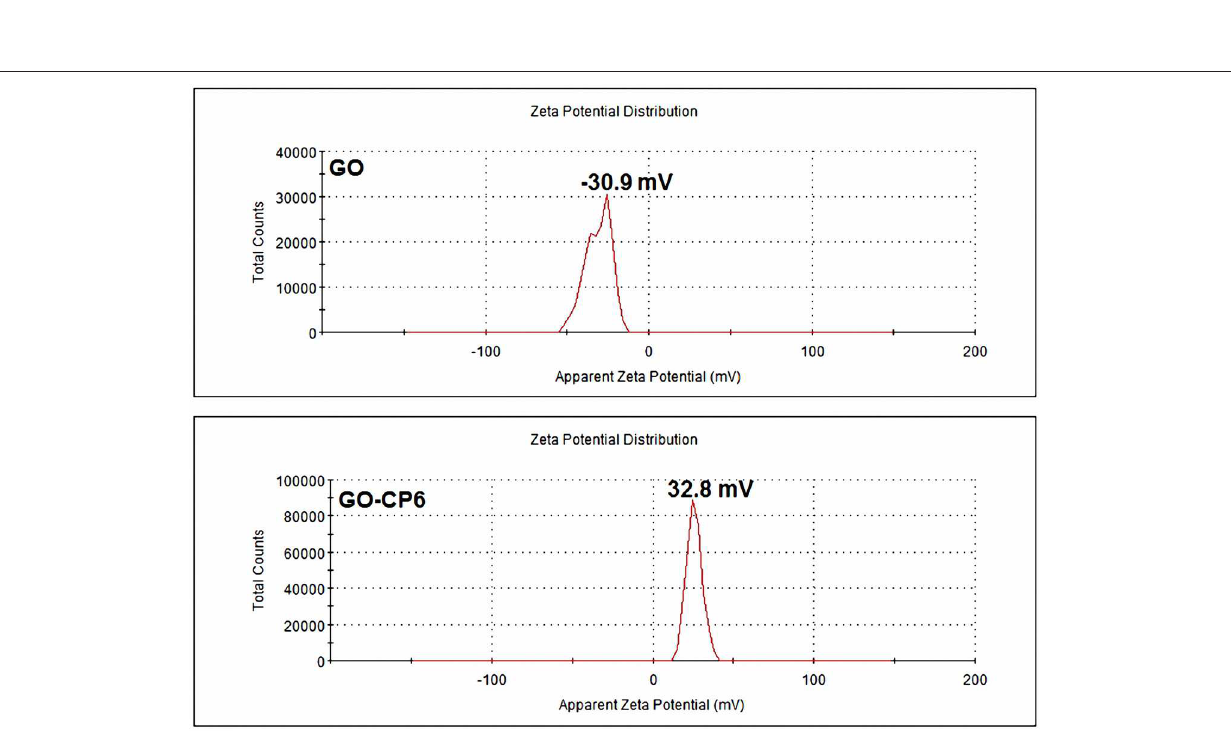
FIGURE 2 | Zeta potentials of GO and